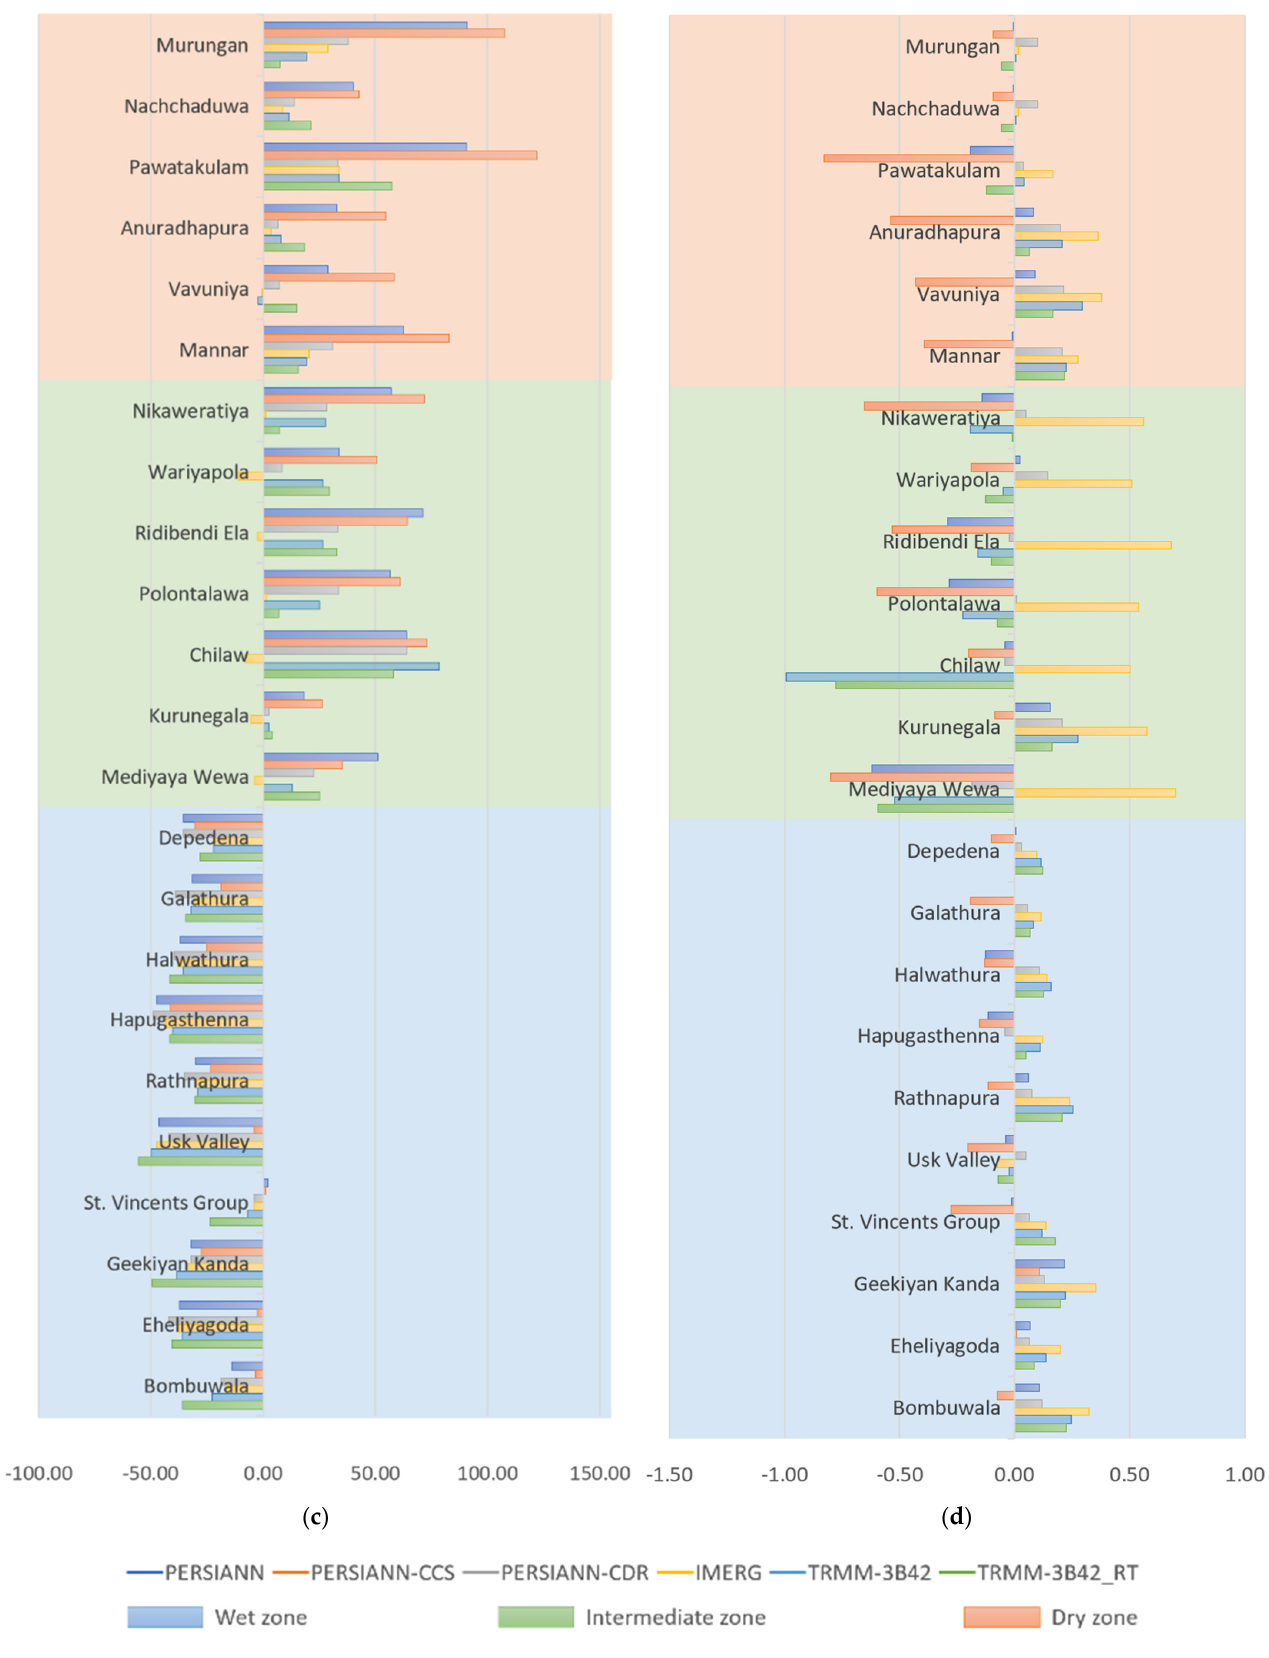
Figure 6. Variation of evaluation indices across the river basins (units are mm/day): ( a ) r; ( b ) RMSE; ( c ) PBias; ( d )